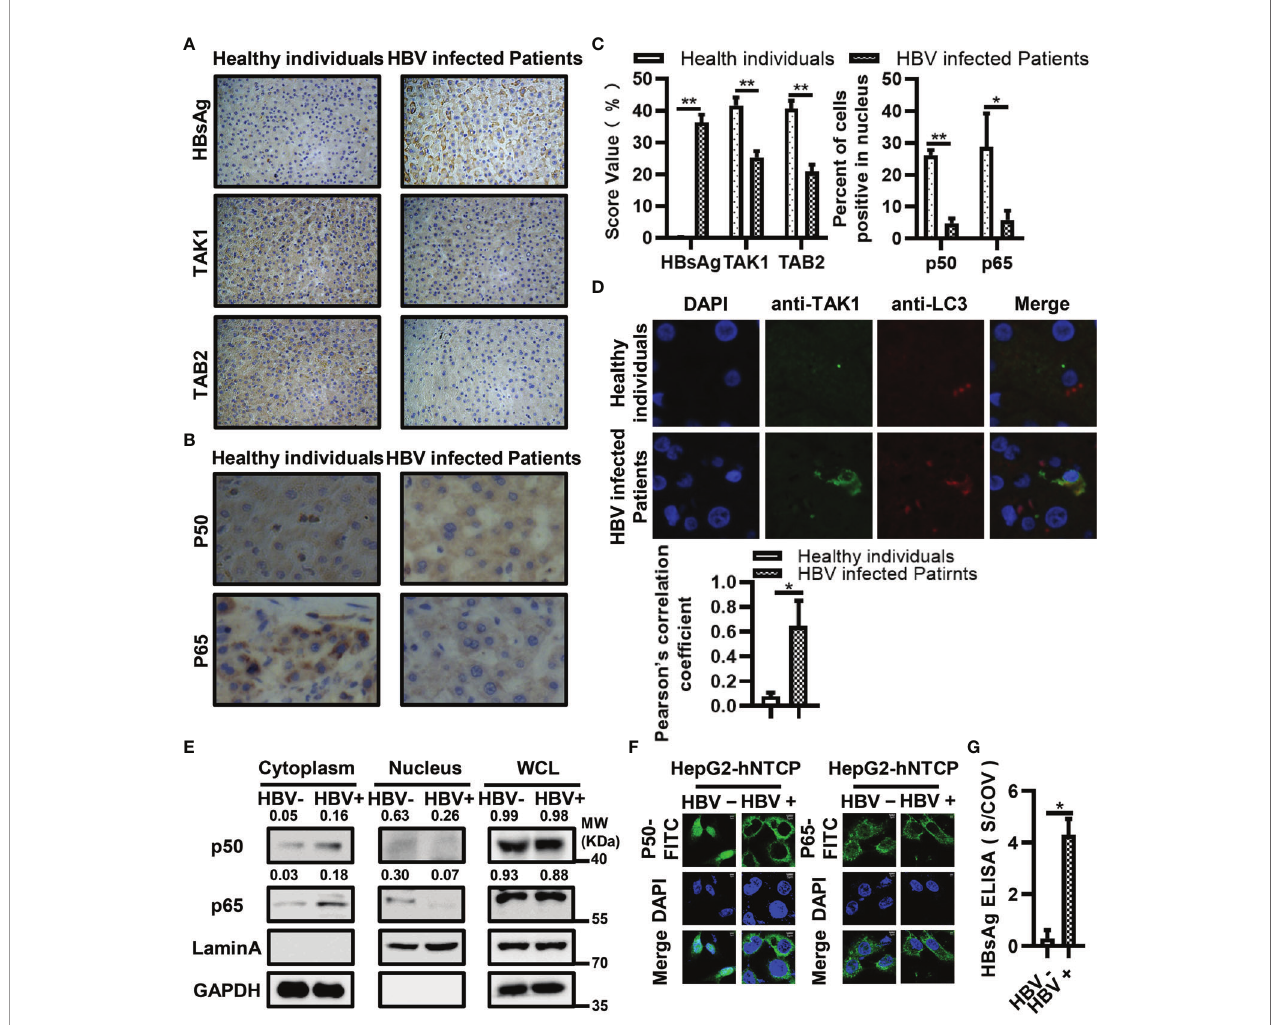
FIGURE 7 | Down-regulated expression of TAK1 and TAB2 and activation of nuclear factor kappa B (NF- k B) in bioptic liver tissues from hepatitis B virus (HBV)- infected patients or HBV infected HepG2-hNTCP cells. (A) Immunohistochemical staining of HBsAg, TAK1, and TAB2 in bioptic liver tissues from the healthy individuals and HBV-infected patients. (B) Immunohistochemical staining of NF- k B subunits (p50, p65) in bioptic liver tissues from the healthy individuals and HBV- infected patients. The magni fi cation times are 400. (C) The abundance of HBsAg/TAK1/TAB2 was assessed by score values after analyzed using Image J. We used the percent of cells p50/p65 located in nucleus to total cell amounts to show the p50/p65 nucleus translocation level. (D) Immuno fl uorescence in bioptic liver tissues was performed to determine the colocalization of TAK1 and LC3. (E) HepG2-hNTCP cells were cultured in collagen-coated six-well plates for 6 h, inoculated with 1,000 multiplicity of genome equivalents of hepatitis B virus (HBV) in primary hepatocytes maintenance medium (PMM) with 4% PEG 8000 at 37°C for approximately 16 h, removed the virus-containing medium, washed with PBS three times and cultured in fresh PMM medium. The medium was refreshed every other day. Cells were harvested for nuclear extraction on 7 days after infection. (F) HepG2-hNTCP cells were plated on collagen incubated in 14-mm confocal dishes with PMM for 6 h, then inoculated with 1,000 multiplicity of genome equivalents of HBV in PMM with 4% PEG 8000 at 37°C for approximately 16 h, removed the virus-containing medium, washed with PBS three times and cultured in fresh PMM medium. The medium was refreshed every other day. Cells were analyzed the translocation of p50 and p65 through immuno fl uorescent staining on 5 days after infection. P50 and p65 were stained with FITC goat anti-rabbit IgG (H+L), and the nuclei were stained with DAPI before observation using confocal microscopy. Scale bar = 5 m m. (G) The supernatant of HepG2-hNTCP on 5 days after HBV infection were collected for HBsAg ELISA analysis. The graphs show the means ± SD, n = 3 (**P < 0.01; *P <